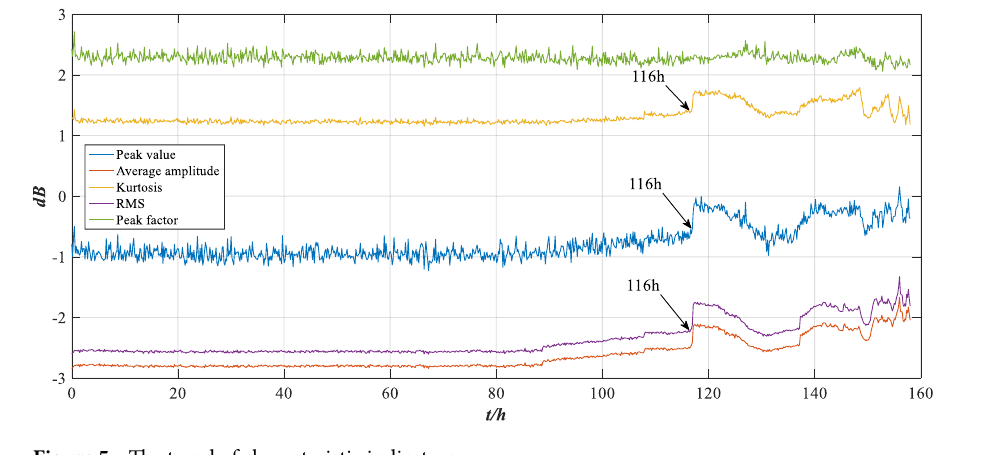
Figure 5. The trend of characteristic